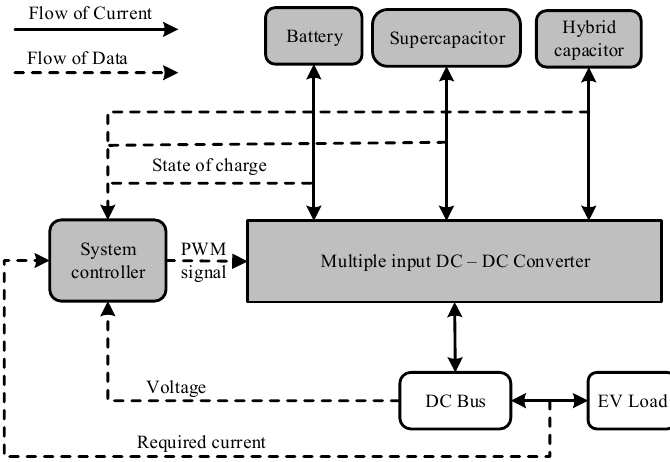
Figure 1. Overview of the concept design, highlighting the major focus areas of this research.